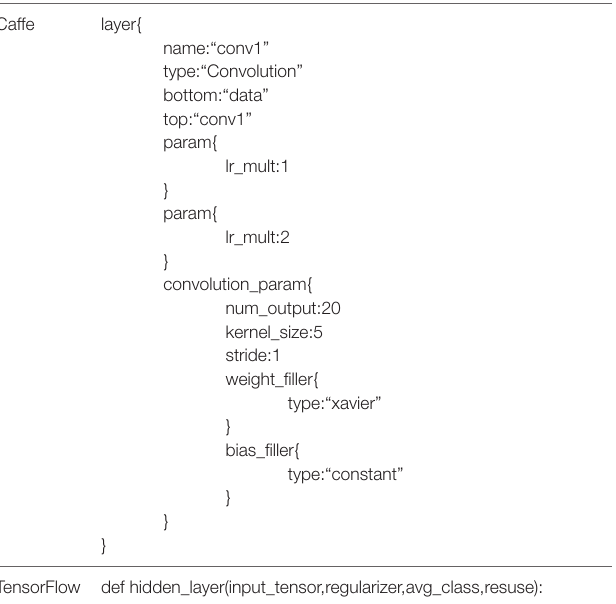
TABLE 4 | Different languages define the code of the first convolution layer of